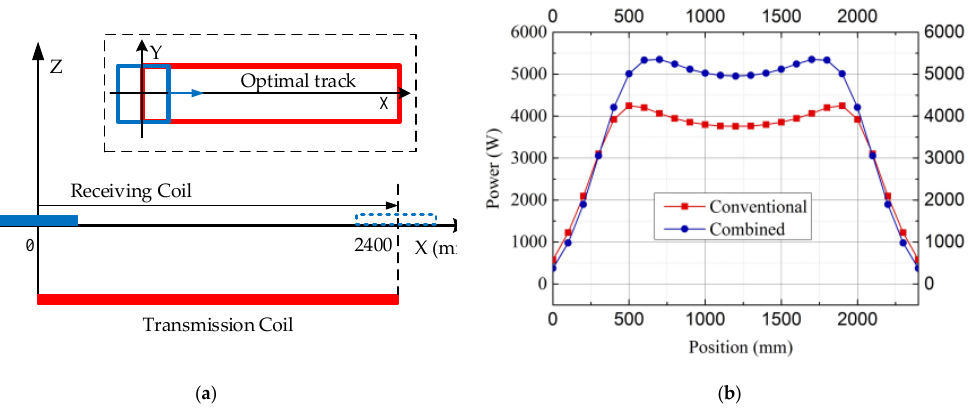
Figure 8. Dynamic charging performance. ( a ) Diagram of dynamic charging procedure; ( b ) Output power comparison of conventional-type and combined-type coils.